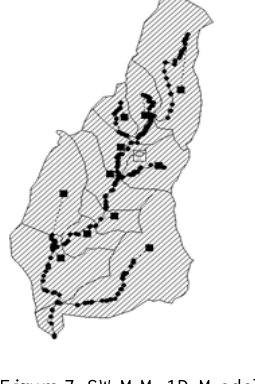
Figure 7: SWMM 1D Model